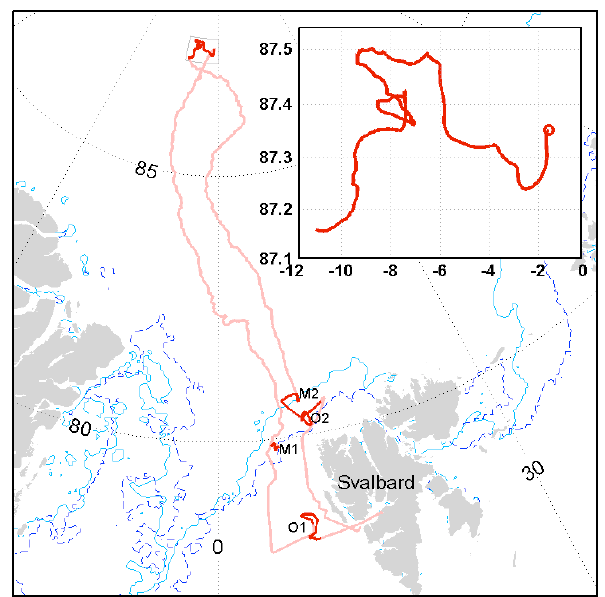
Figure 1. Map of the ASCOS cruise track (pink) with ice-drift period (PI-drift) highlighted (red) and (inset) shown in detail with the start of the drift marked by the circle. The left-hand part of the track shows the initial northward track while the right-hand part shows the southward, return track. Convoluted track lines in open water, OW (O1 and O2) and at the ice edge, MIZ (M1 and M2) are associated with shorter sampling stations. The light blue line illustrates the ice edge at the time of entry and the darker blue line at the time of drift period on 12 August 2008 (courtesy of I. Brooks).